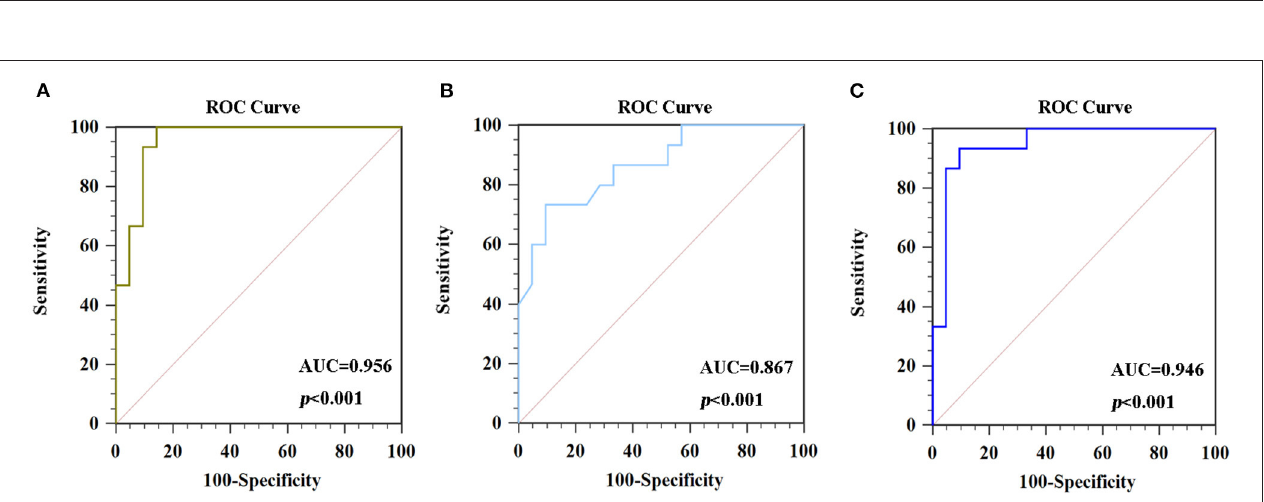
FIGURE 3 | The post hoc comparison of the average signals in altered brain regions. (A) Comparison of ReHo values in the CAL.L; (B) Comparison of ReHo values in the SFG.L; (C) Comparison of fALFF values in the IPL.L; * p < 0.05, ** p < 0.01, *** p < 0.001; SG0W, post-stroke depressive patients before treatment; SG8W, post-stroke depressive patients after 8 weeks treatment; HC, healthy controls; ReHo, regional homogeneity; fALFF, fractional amplitude of low-frequency fluctuation; CAL.L, left calcarine sulcus; SFG.L, left superior frontal gyrus; IPL.L, left inferior parietal cortex.